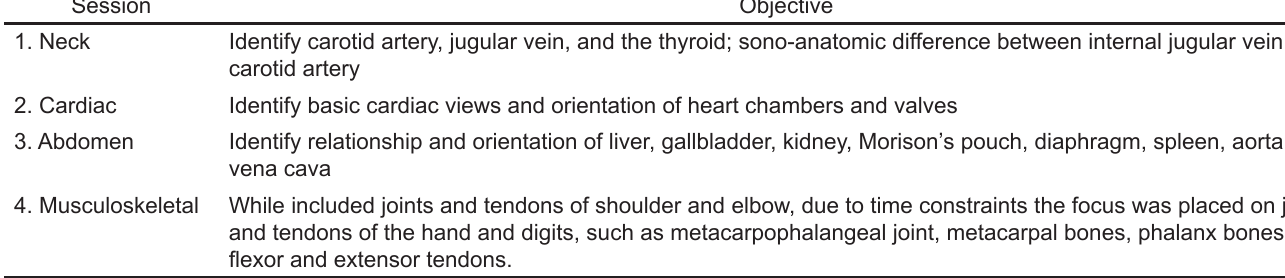
Table 1. Ultrasound curriculum for PGY (postgradutae year)-1 anatomy lab sessions.